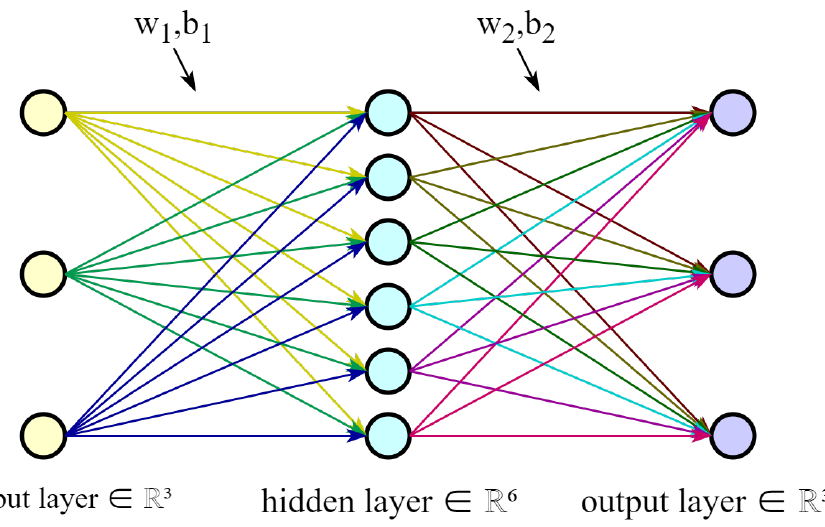
Figure 3. The structure diagram of a single hidden layer MLP. The depth of the network is 3, and the number of neurons in the input layer, hidden layer, and output layer is 3, 6, and 3,